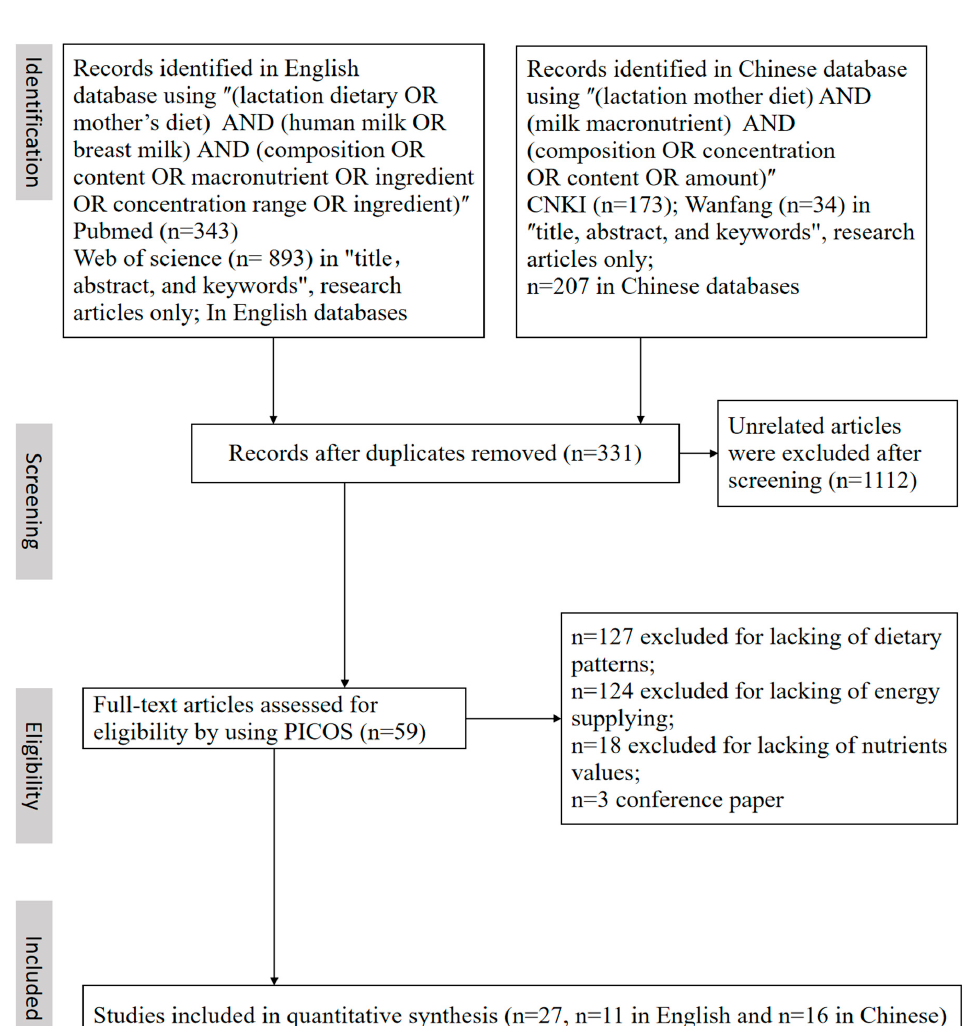
Figure 1. Flow chart of literature searching and screening. (PRISMA). The process of selecting the articles that meet the inclusion and exclusion criteria was listed in the PICOS table (Table